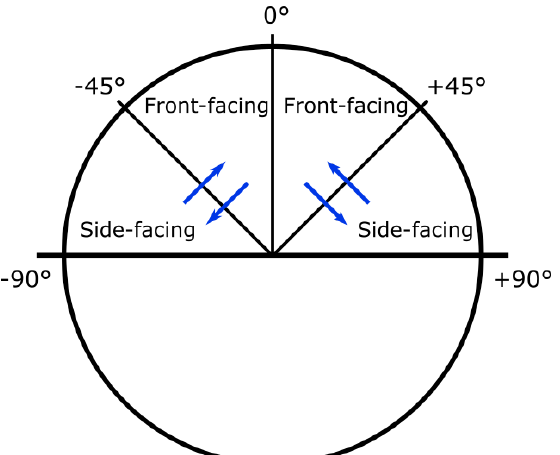
Figure 15. A bird’s-eye view of the human face. The blue arrows indicate the directions the automatic rotation function will rotate the face in, given the right yaw angles.